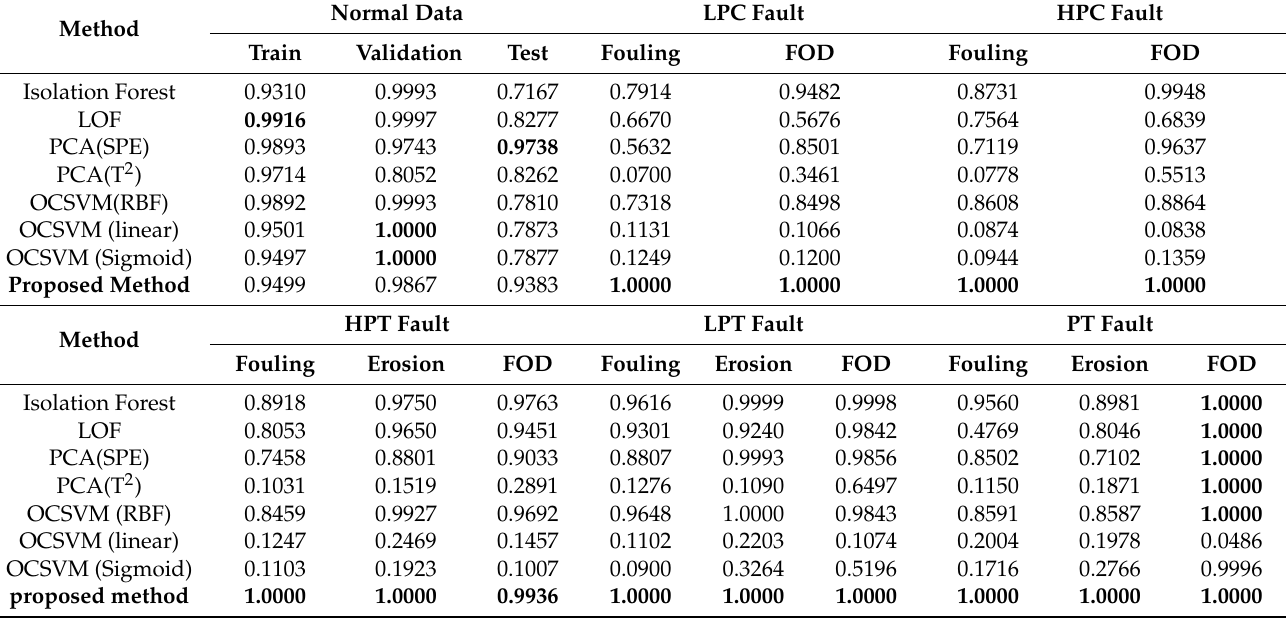
Table 8. Fault detection accuracy comparison with one-class classifiers.